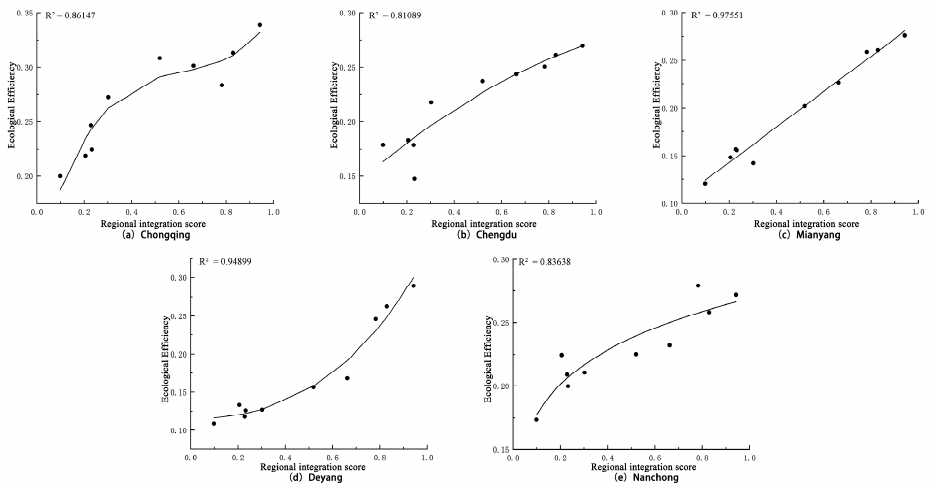
Figure 4. Regional integration of the CCUA linearly improved the EEs of some cities from 2011 to 2020.